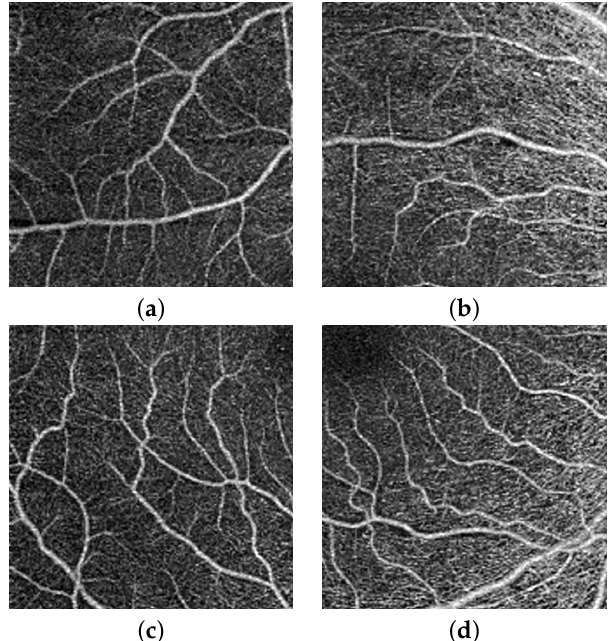
Figure 3. The four parts of OCTA image with equal size (512 × 512): ( a ) upper left, ( b ) upper right, ( c ) lower left, and ( d ) lower right quarter.